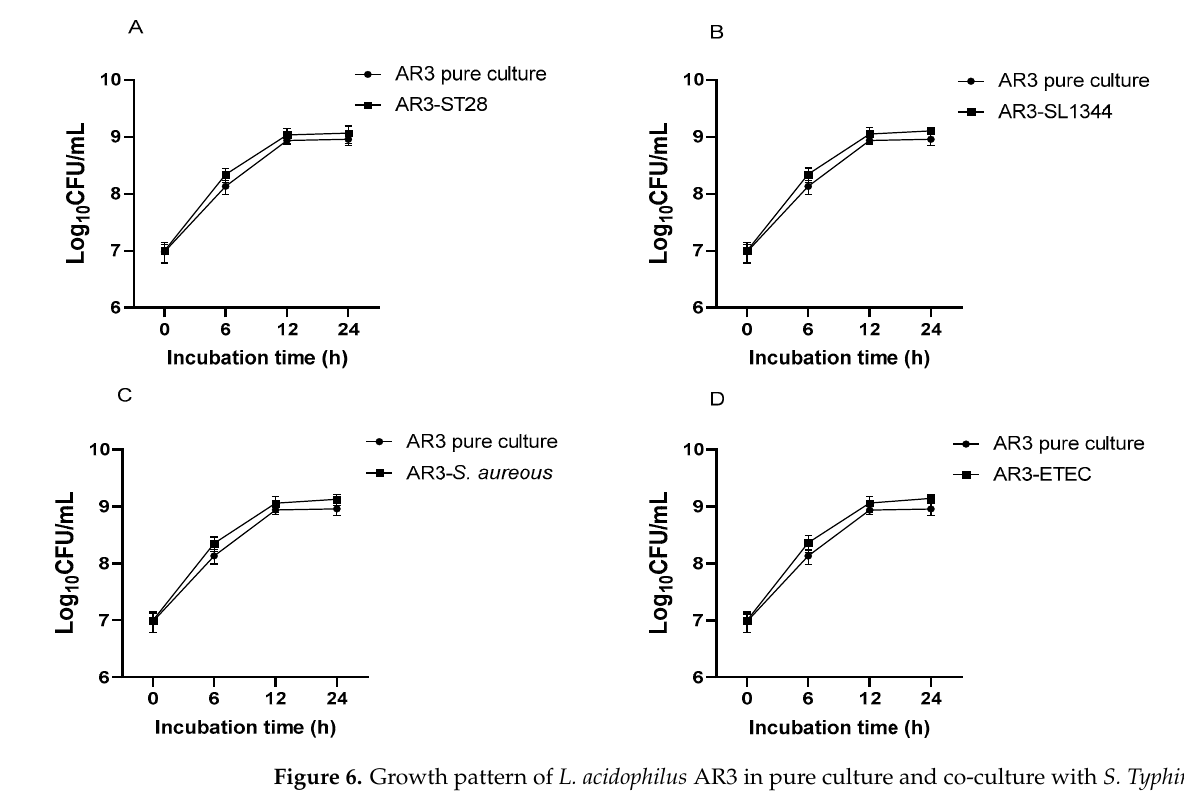
Figure 6. Growth pattern of L. acidophilus AR3 in pure culture and co-culture with S . Typhimurium ATCC14028 ( A ), S . Typhimurium SL1344 ( B ), S. aureus ( C ), and ETEC ( D ).